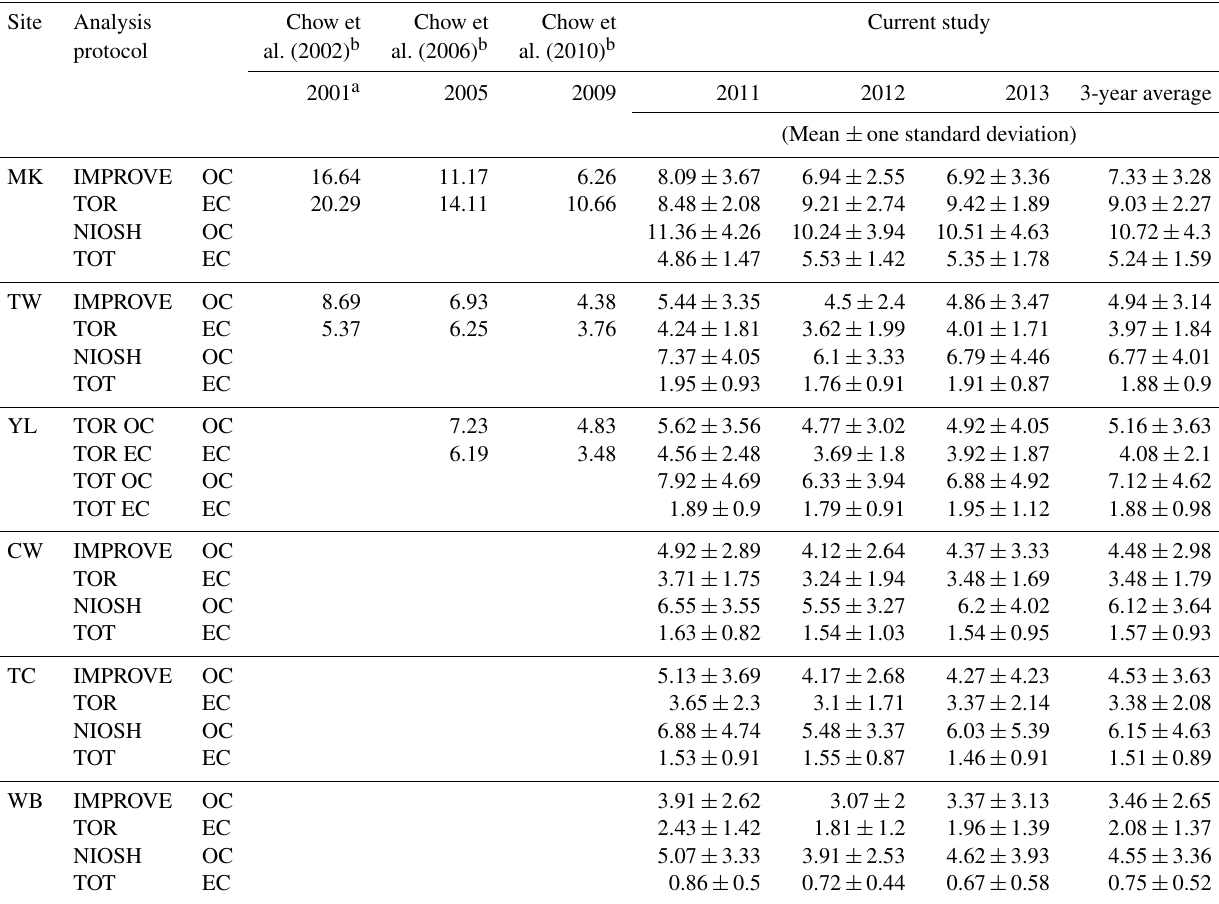
Table 1. Ambient mean concentrations (µgm − 3 ) of OC and EC for six sites in Hong Kong by IMPROVE TOR and NIOSH TOT